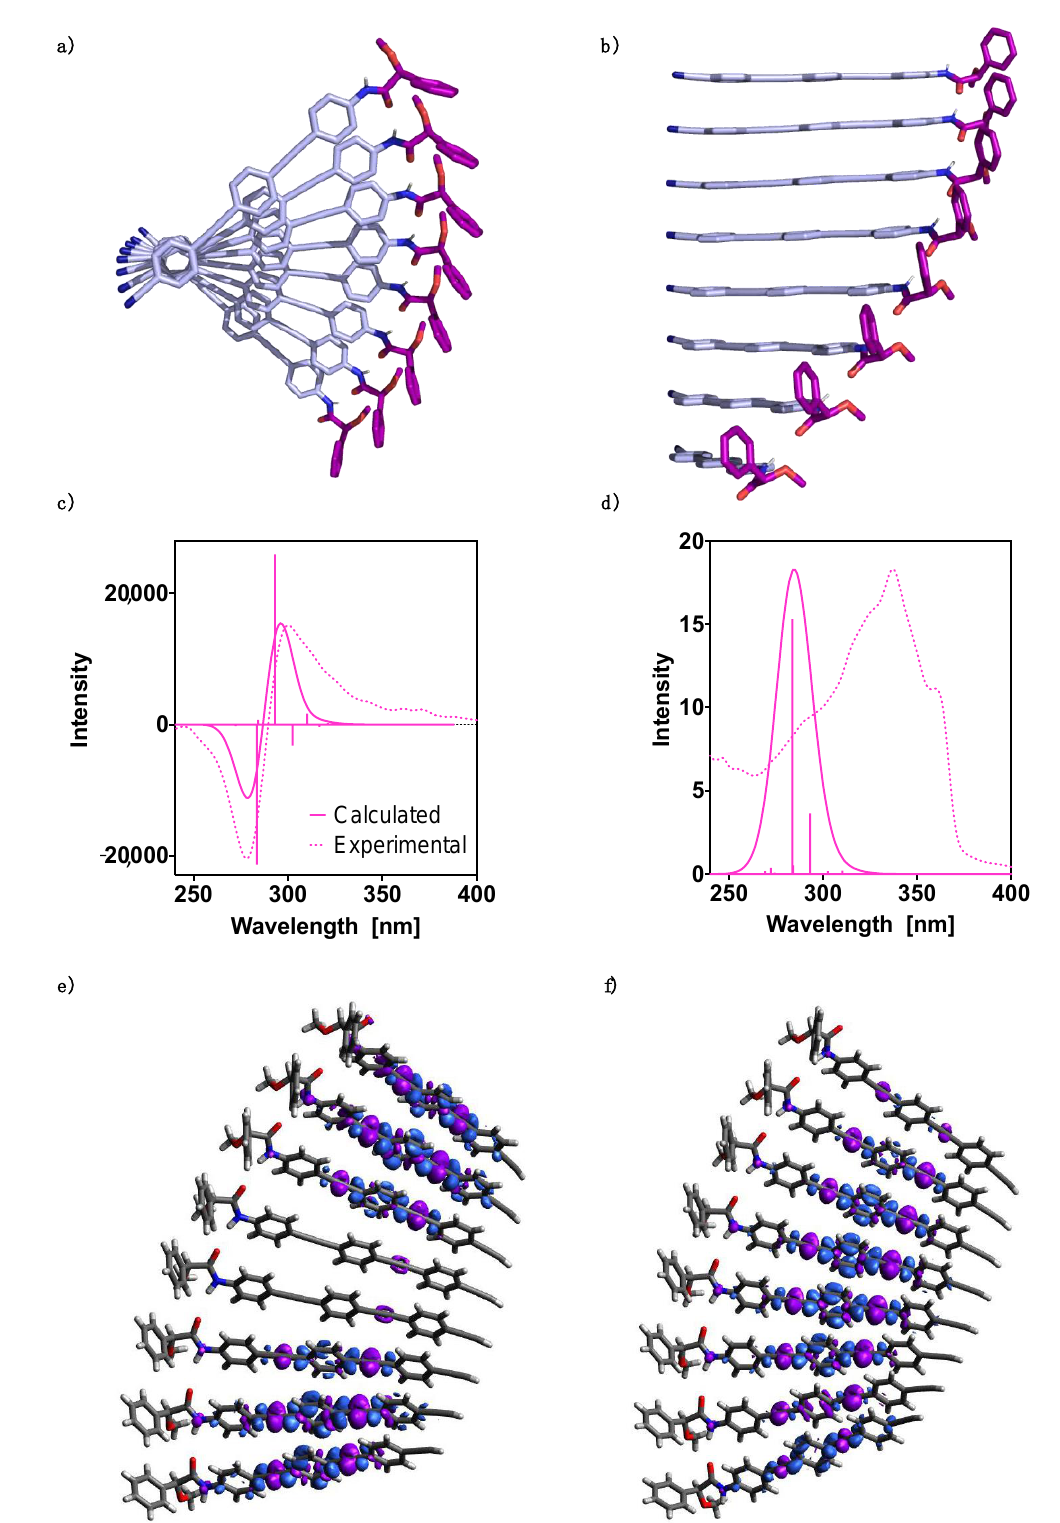
Figure 5. Oligo(phenyleneethynylene) (OPE) ( S )- 1 hh 8-mer structure: ( a ) perpendicular view and ( b ) hh parallel view. TD-DFT (CAM-B3LYP)/3–21G spectra: ( c ) ECD and ( d ) UV-Vis. The corresponding experimental spectra are plotted for comparison. No correction factors are included in the theoretical wavelengths. Electron density differences (purple color negative and blue positive, isovalue = 0.0002) for transitions: ( e ) S 0 → S 7 and ( f ) S 0 → S 9 .